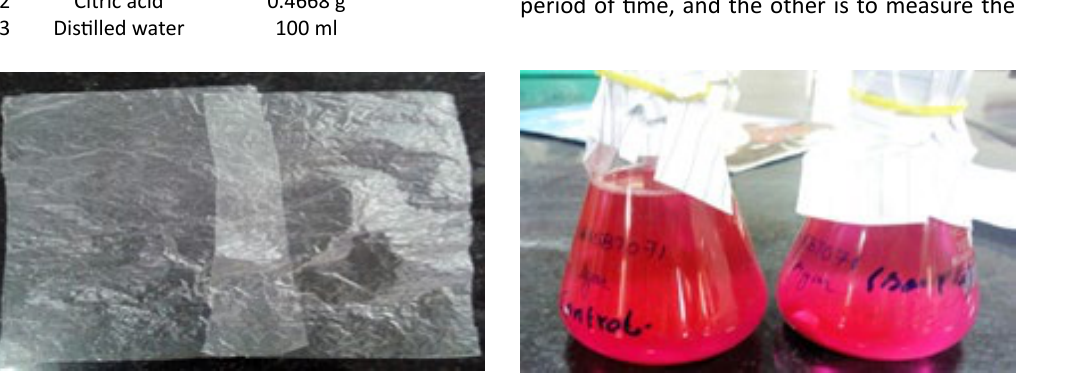
Fig. 1. Low Density Polyethylene Fig. 2. Low Density Polyethylene Sheets in Rose Bengal